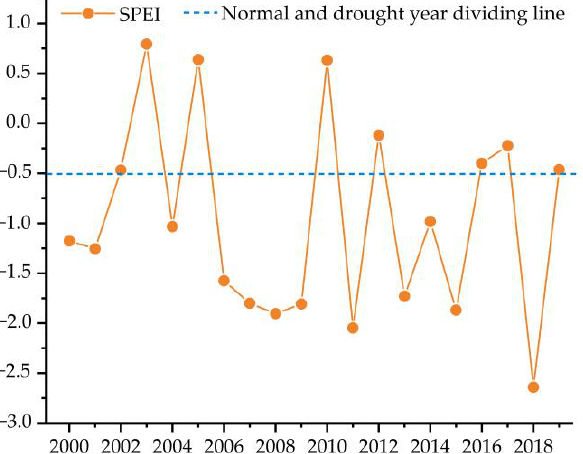
Figure 6. Change in SPEI in Hotan from 2000 – 2019.